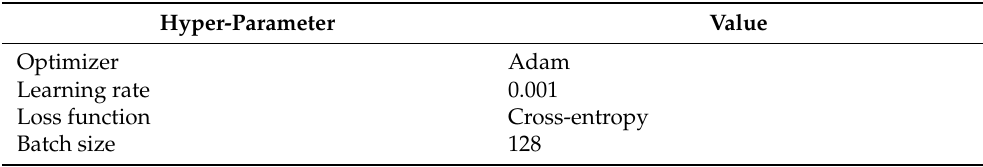
Table 5. The hyper-parameters of CNN architecture for the multi-patch-based model.